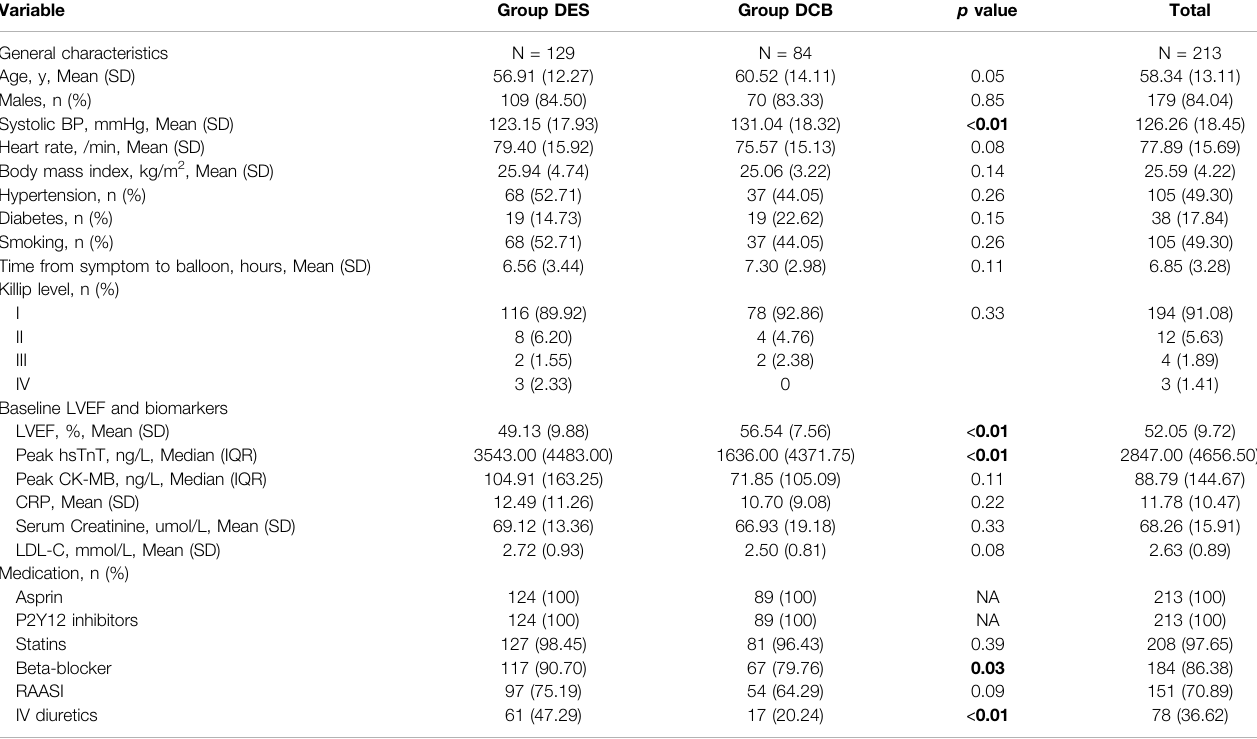
TABLE 1 | Baseline characteristics of the study population.